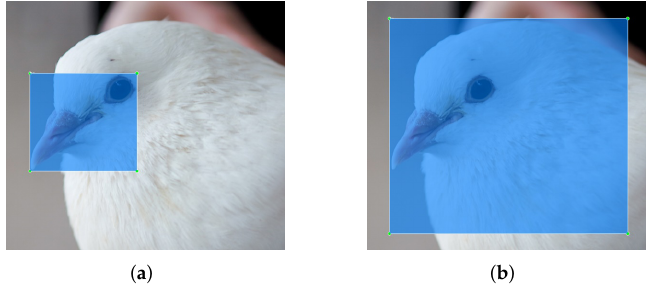
Figure 4. Labeled area for feature extraction. ( a ) The eye-beak compound area is labled. ( b ) The entire head is